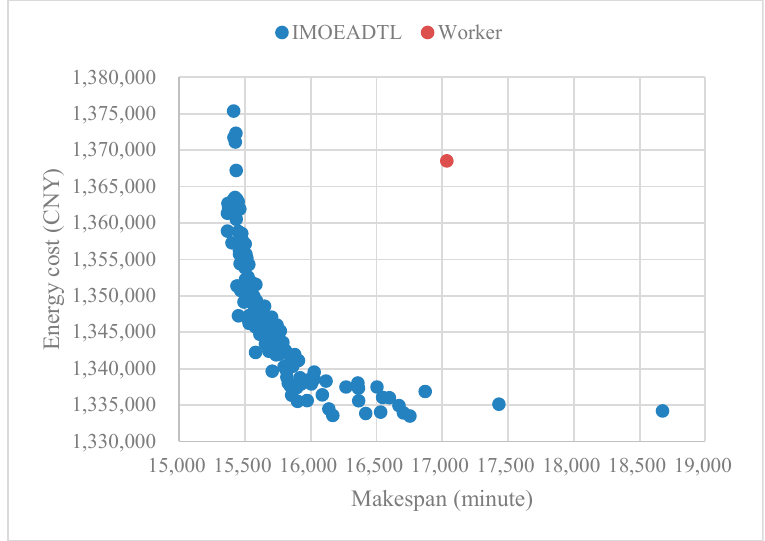
Figure 7. The scatter plot for the solutions obtained by IMOEA/DTL and a worker.